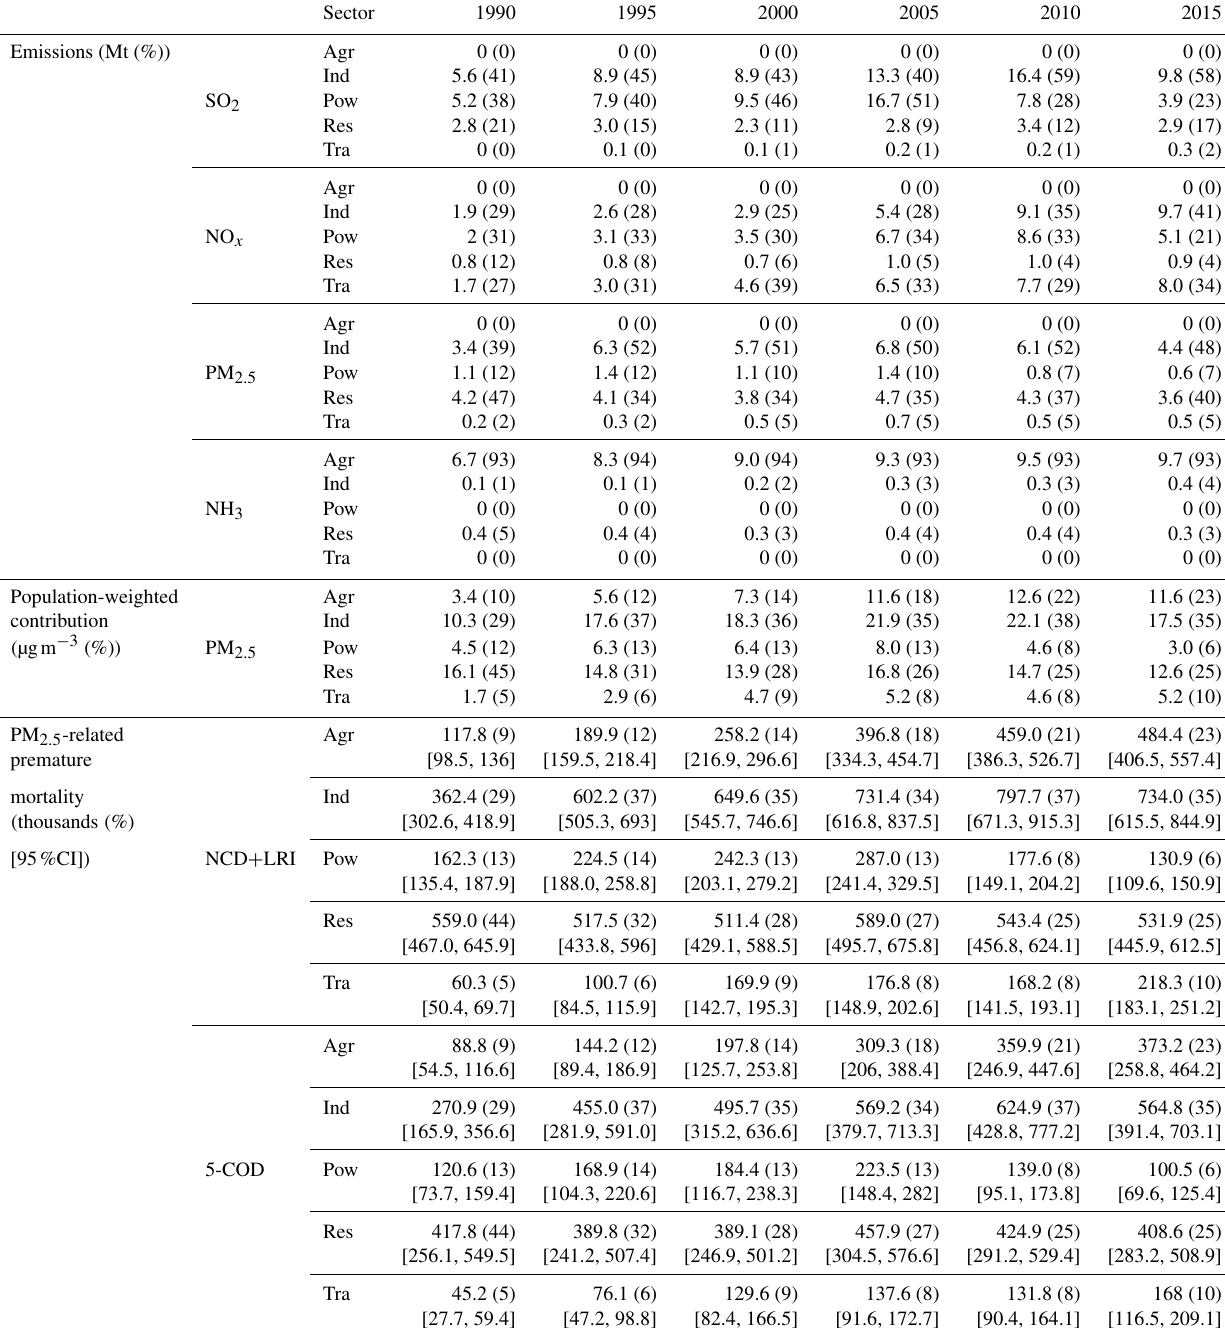
Table 2. SO 2 , NO x , PM 2 . 5 , and NH 3 emissions; population-weighted PM 2 . 5 concentration; and PM 2 . 5 -related premature mortality con- tributed by the agricultural (Agr), industrial (Ind), power (Pow), residential (Res), and transportation (Tra)